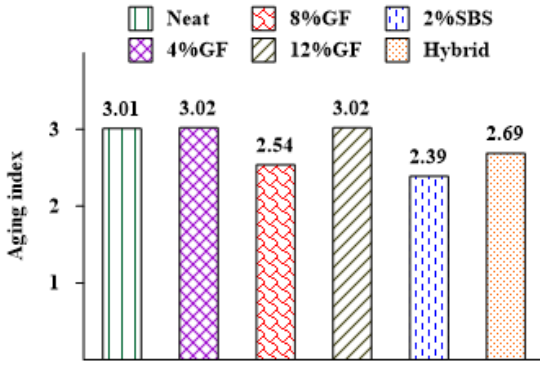
Figure 12. Additives’ influences on the aging indexes of asphalt